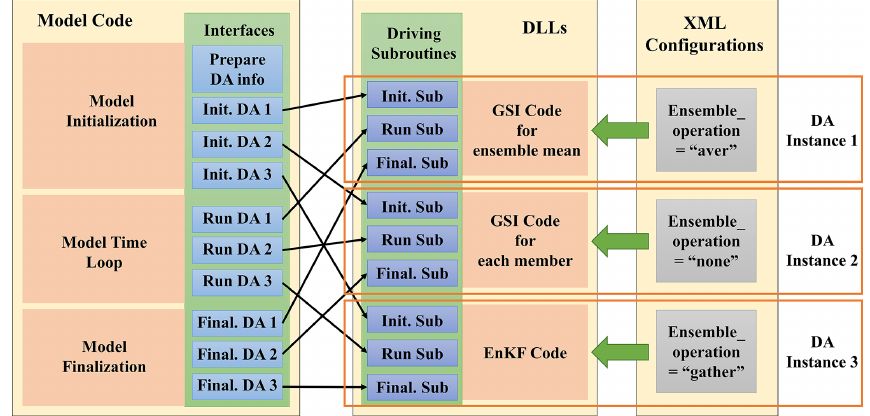
Figure 9. Modifications of model code and the invoking of relationships to the DA algorithm in the example ensemble DA system.